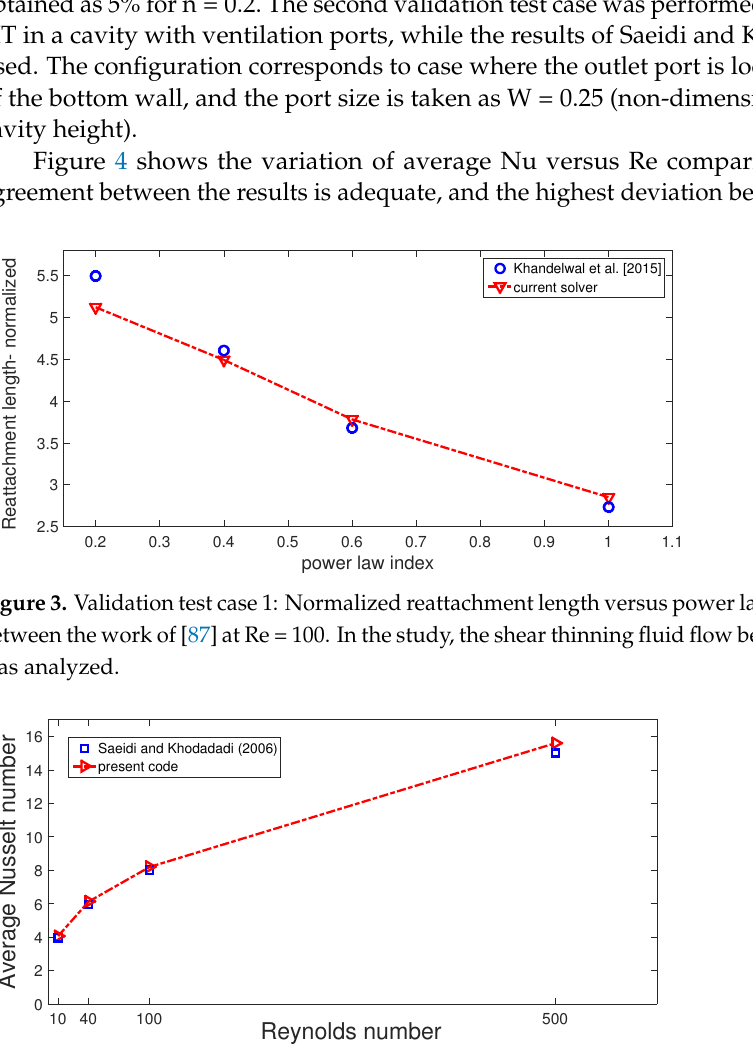
Figure 4. Validation test case 2: Average Nu versus Re comparisons using the available results of [1]. In the work, the convection characteristics in a ventilated cavity were